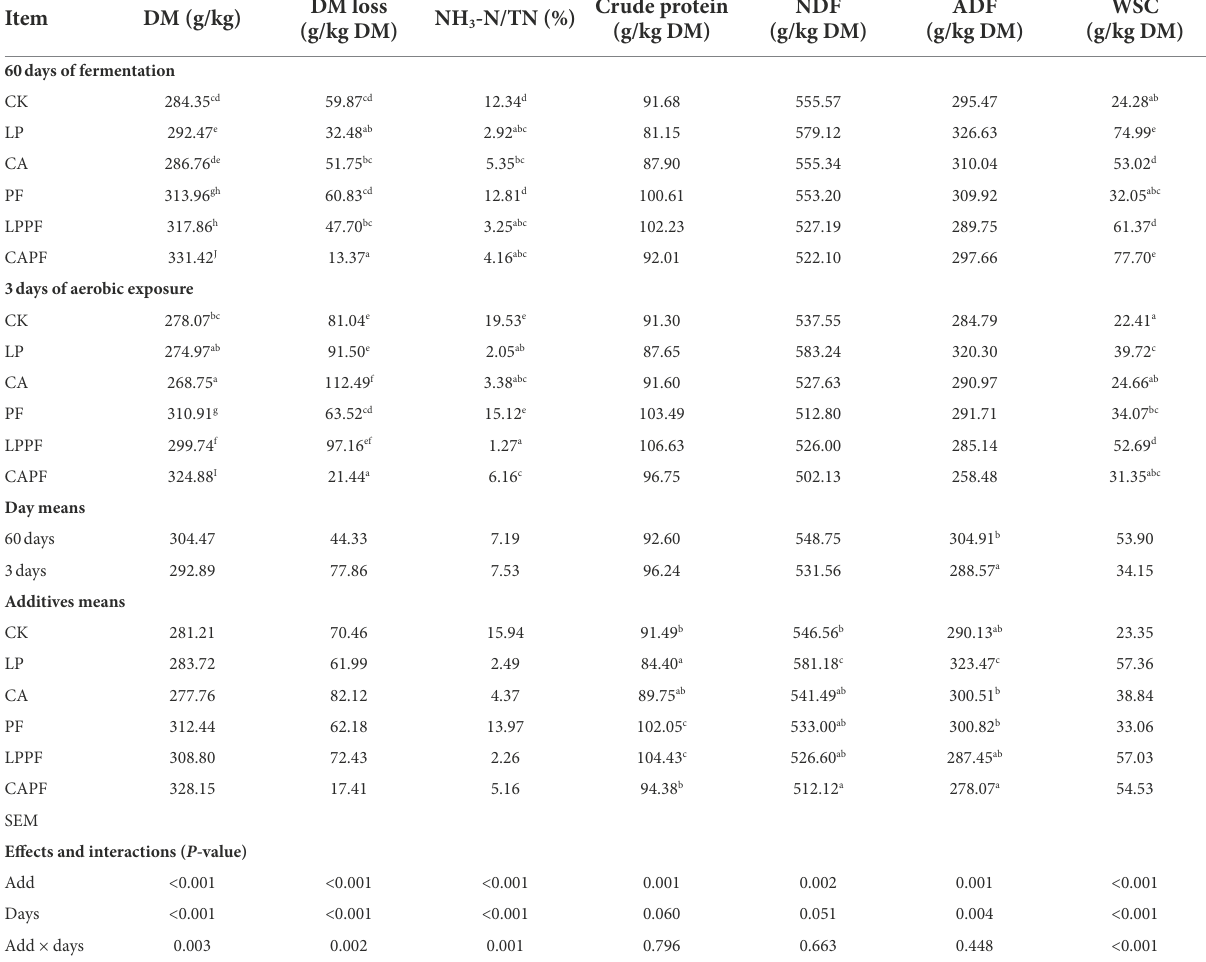
TABLE 3 Chemical compositions of forage oat silages during aerobic